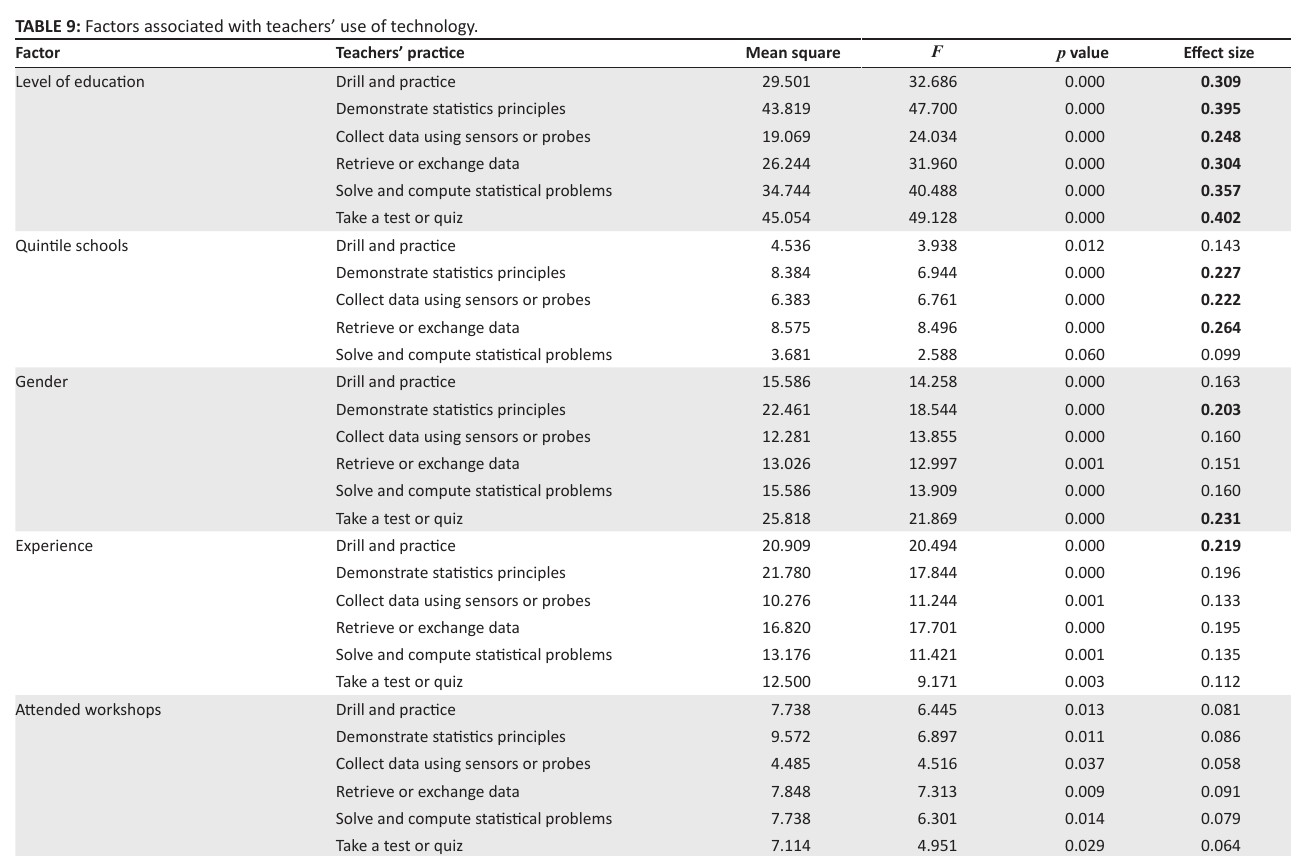
TABLE 9: Factors associated with teachers’ use of technology. Factor Teachers’ practice